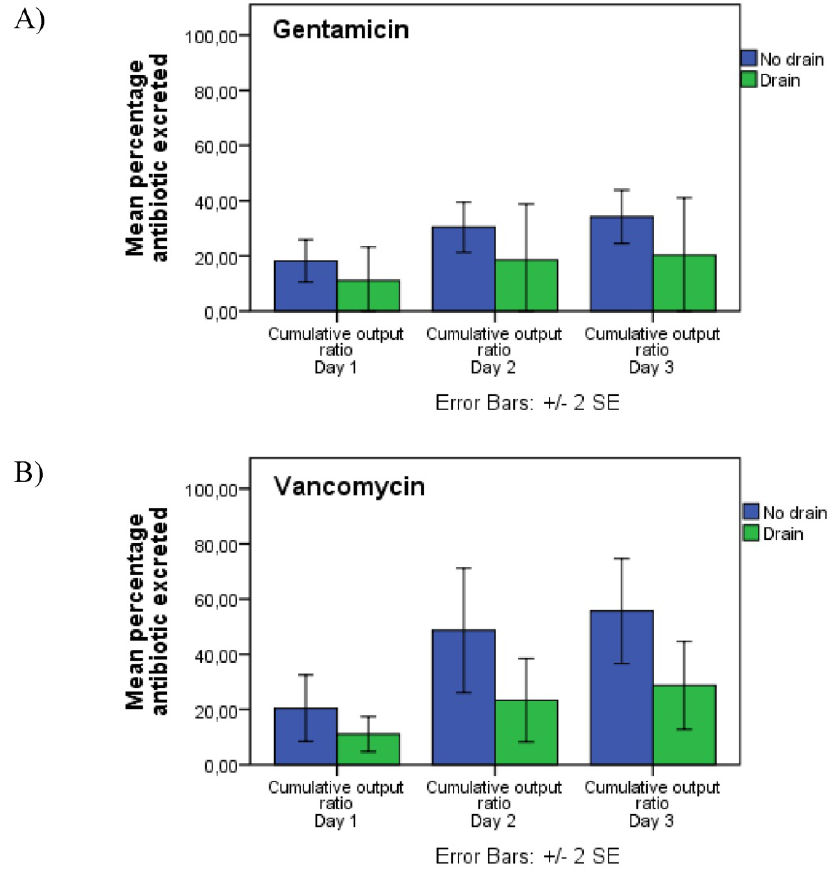
Figure 3. Cumulative urine output of (A) gentamicin and (B) vancomycin. Blue bars indicate patients without a surgical drain and green bars indicate patients with a surgical drain. Error bars indicate standard error of